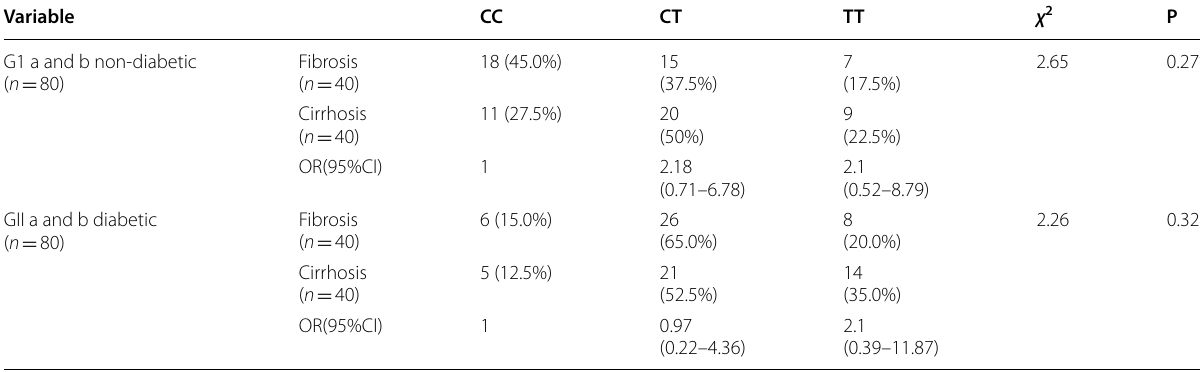
X 2 Chi-square test *: nonsignificant =